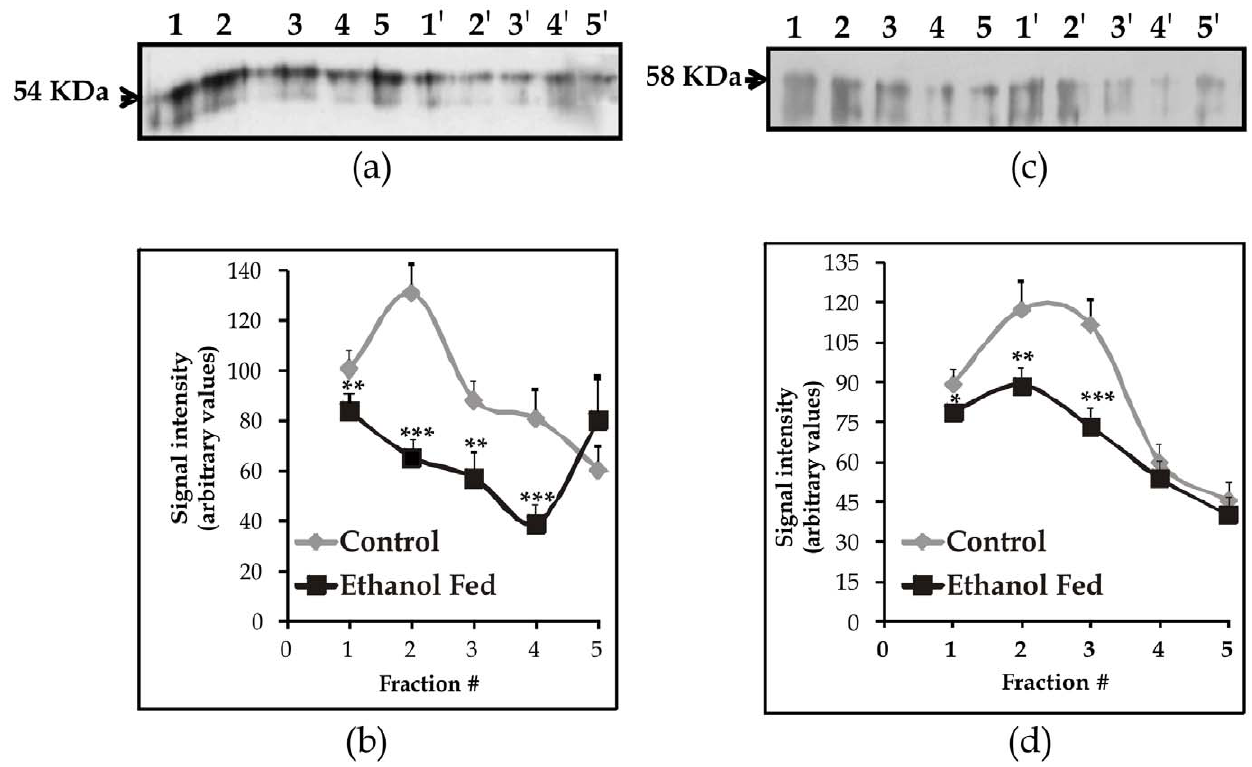
Figure 6. Association of folate transporters (PCFT & RFC) proteins with lipid rafts in pancreatic apical membrane. The pancreatic plasma membrane vesicles were subjected to floatation on Optiprep density gradients, and fractions were collected from top of the gradients (fractions 1–4 represent detergent-resistant membrane). Fractions were separated by electrophoresis and analyzed by Western blotting using a) anti- PCFT (54 kDa) and b) RFC (58 kDa) antibodies. Blots were scanned, and the intensity of bands was determined by densitometric analysis. Data are means 6 SD of 4 separate experiments. The representative blot shown for PCFT and RFC expression as, lane 1–5: Control; lane 1 9 –5 9 : ethanol fed. * p , 0.05 ** p , 0.01, *** p , 0.001 vs. Control.